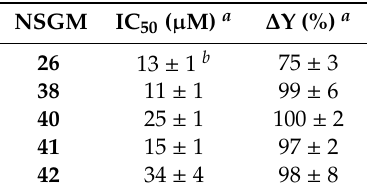
Table 2. Direct inhibition of MMP-8 by selected NSGMs.